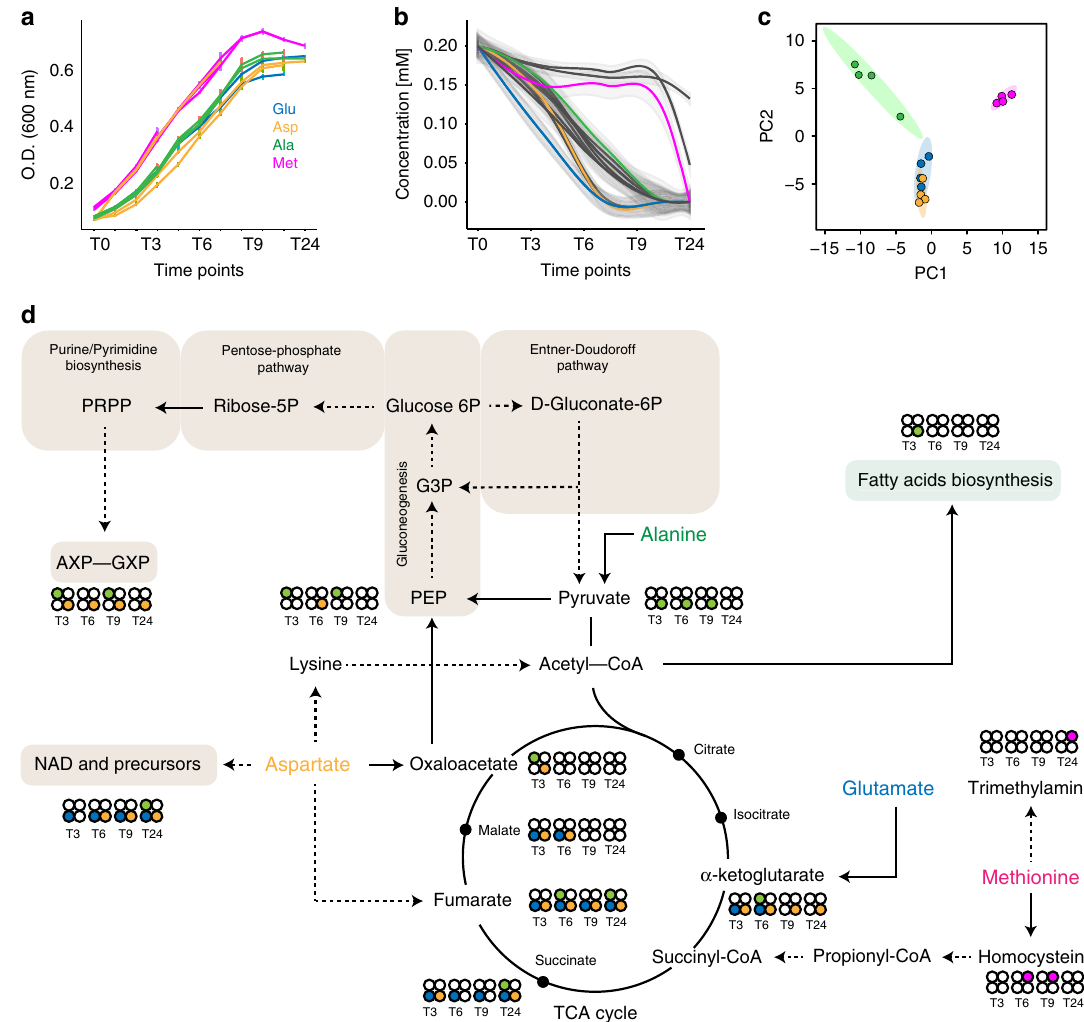
Fig. 5 The fate of catabolized amino acids. a PhTAC125 growth curves across all replicates in the 19 AA medium with one of them being 13 C labelled. Each colour indicates which was the 13 C-labelled amino acids for each replicate. Error bars represent SD of four different cell cultures. b Extracellular concentration of all the amino acids in time. Colour codes as in a . c PCA on the 13 C spectra. Colour codes as in a . Grey shaded area includes the 95% con fi dence of the linear regression (coloured) line over the concentrations of the amino acids belonging to the same group. d Central PhTAC125 metabolic network, highlighting the possible entry points of the labelled amino acids. Circles close to compounds indicate the 13 C signal recovered at the different time points (T3 – T24) and coming from different amino acids (colour codes as in a ) corresponding. Source data are provided as a Source Data fi